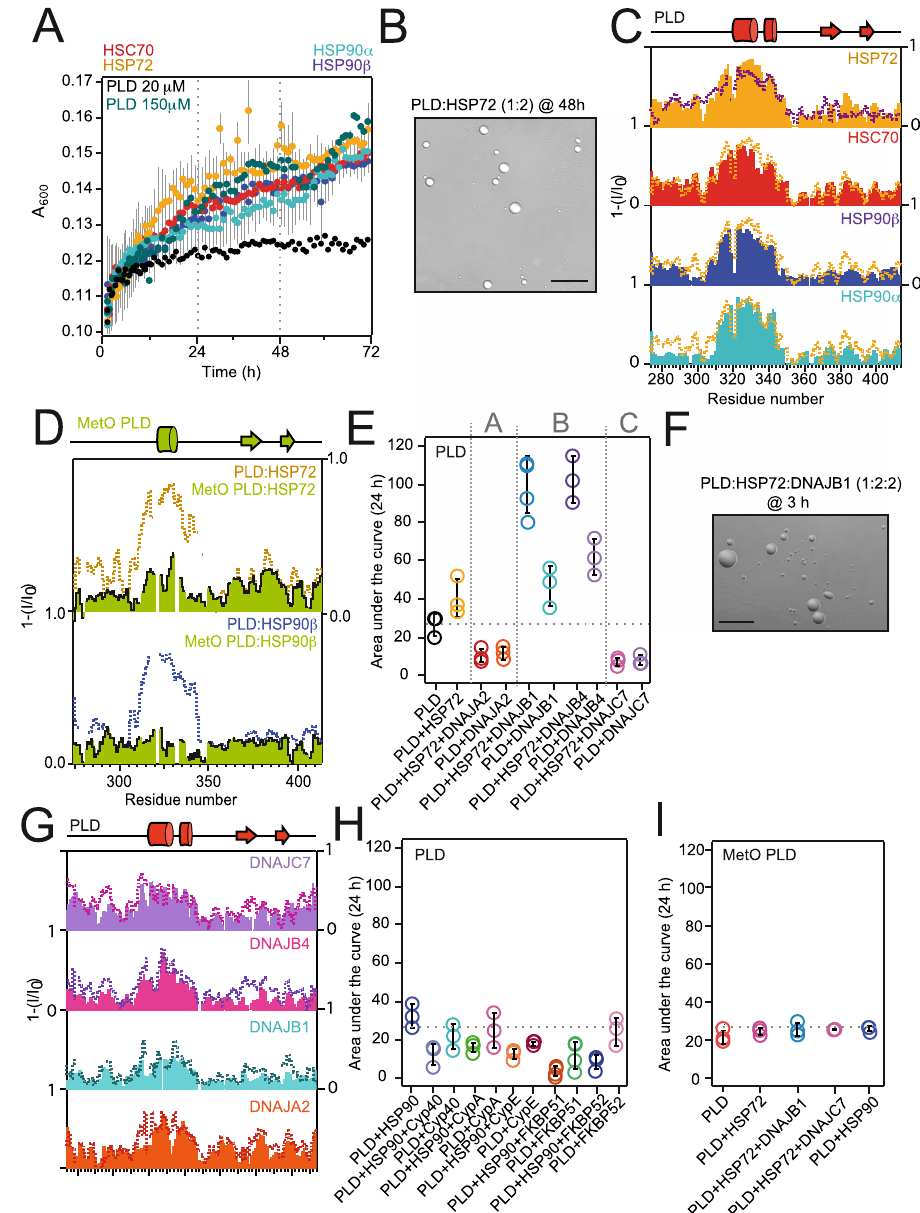
Fig. 4 | The interplay with chaperones and co-chaperones is mediated by the double α -helix of the PLD. A Turbidity measurements of the PLD in presence of the indicatedchaperones (allin 1:2 molarratios).Errorbars arenotincluded inthe PLD plot (black dots) for clarity. B DIC microscopy image of the condensates formed by 20 μ M PLD in complex with HSP72 after 48h of incubation at 25°C. C NMR signal intensity plots of 25 – 35 μ M PLD in complex with the indicated cha- perones(allin1:2molarratios).Forcomparison,theplotsareoverlaidwiththedata corresponding to de-mixed PLD (300 μ M PLD, broken purple line, Fig. 1F) and HSP72interaction(orangebroken line). D NMR intensity plots forMetO PLD inthe presence of the chaperones (green bars) in comparison to the unmodi fi ed PLD:chaperoneinteractionsinidenticalmolarratios(brokenlines). E LLPSof20 μ M PLD in the presence of HSP72 and/or JDPs represented asthe area under the curve of the turbidity measurements after 24 h. Vertical broken lines separate the three